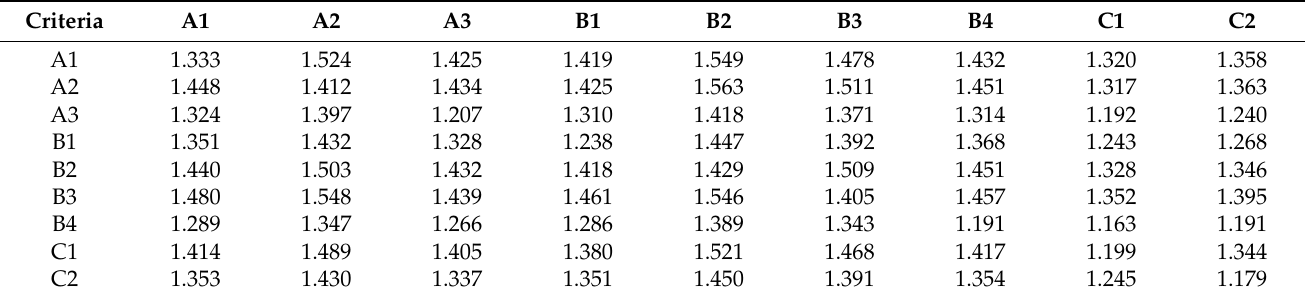
Table 5. Unweighted Supermatrix (T*).